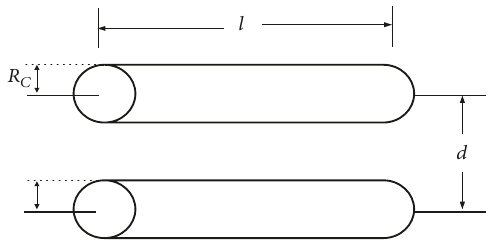
Figure 10: Features of two parallel conductors to measure the mutual